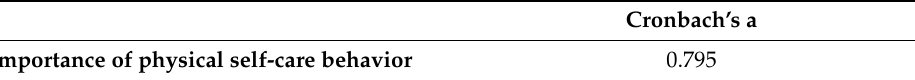
Table 4. Reliability:Internal Consistency.